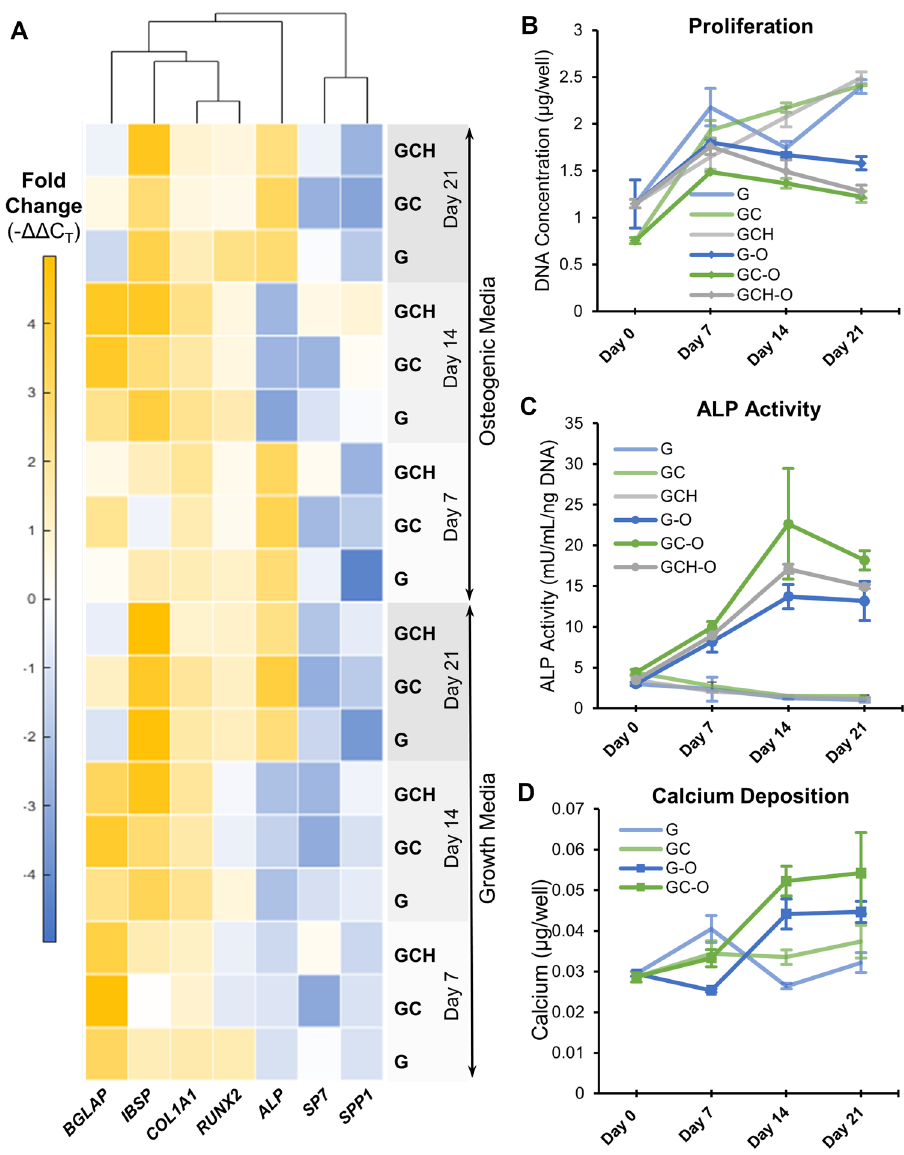
Figure 5. Osteogenicity of microgels with chitosan and hydroxyapatite. ( A ) Osteogenic gene expression of MSC seeded in microgels. The osteogenic genes analyzed include osteocalcin (BGALP), bone sialoprotein (IBSP), collagen type I (COL1A1), Runt-related transcription factor 2 (RUNX2), alkaline phosphatase (ALP), osterix (SP7), and osteopontin (SPP1). ( B ) MSC proliferation deduced from total DNA content, ( C ) ALP activity quantified using a commercial kit, ( D ) calcium deposition quantified using OCPC assay. GCH-group excluded due to very high background from the added HA (n = 3). Bar chart legend: G-Gelatin only, GC-Gelatin + 0.25% Chitosan, GCH-Gelatin + 0.25% Chitosan + 1%HA. The suffix -O indicates osteogenic